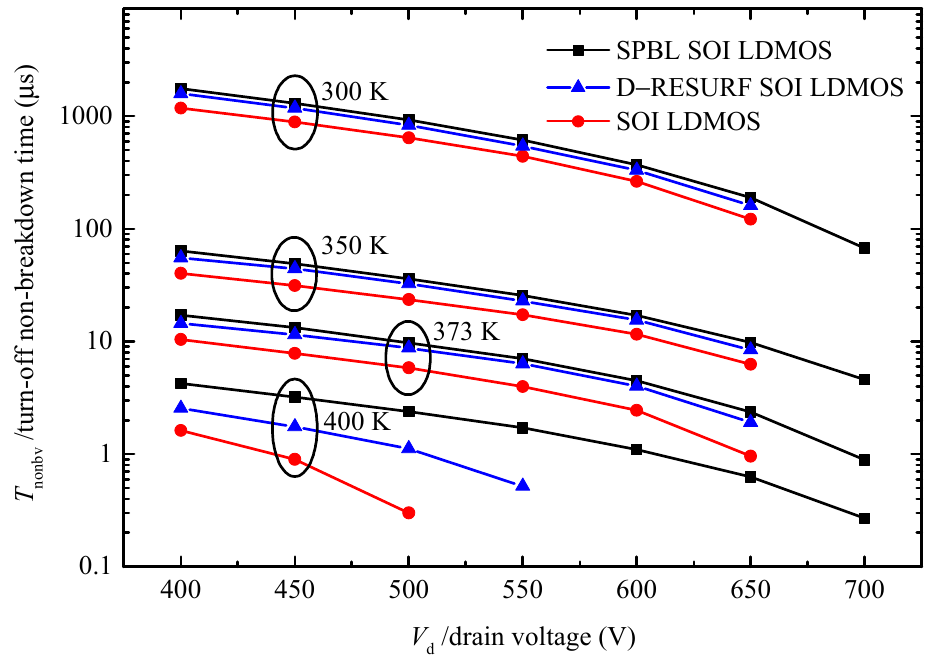
Figure 7. Relationship between T nonbv and V d at di ff erent device temperatures.